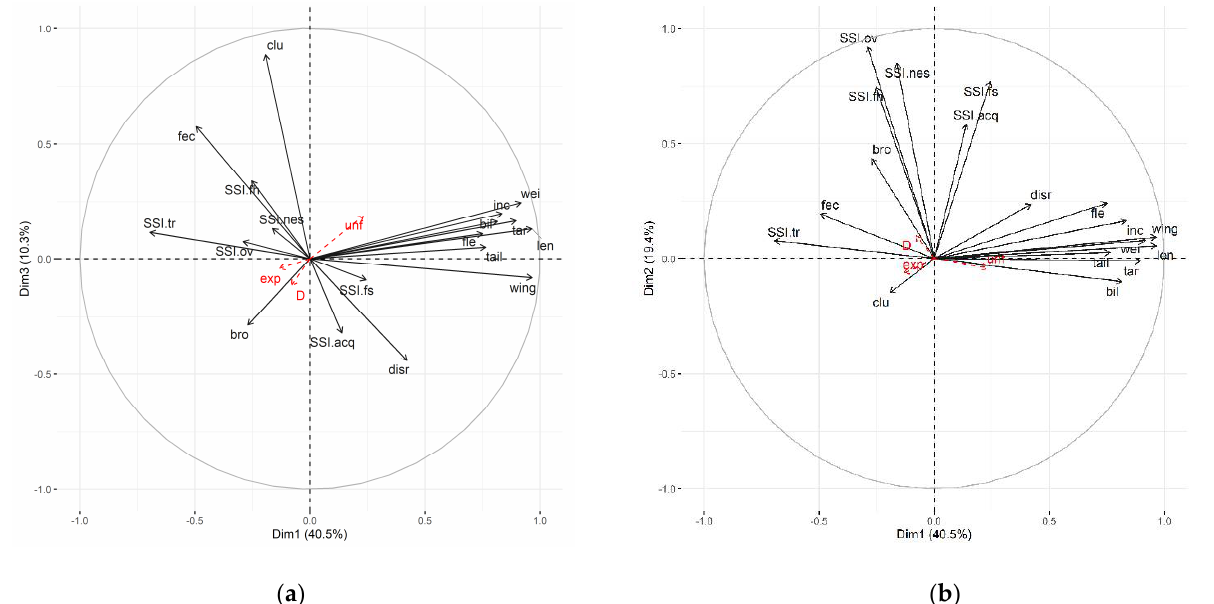
Figure 6. Relationship between niche metrics, life-history and ecological continuous traits. PCA bip- lot between the Schoener’s D (D), unfilling (unf) and expansion (exp) niche metrics (red and dashed arrows) and the 18 continuous traits (solid black arrows) respect to Dim1 and Dim3 ( a ) and to Dim1 and Dim2 ( b ). Abbreviations’ meaning for the continuous traits: len = body length; wing = wing length; tail = tail length; bil = bill length; tar = tarsus length; wei = body weight; clu = clutch size; bro = number of broods per breeding season; fec = annual fecundity; inc = incubation period; fle = fledg- ing period; disr = dispersal ratio; SSI. = prefix for the specialization indices; fh = foraging habitat; acq = acquisition behavior; nes = nesting habitat; fs = foraging substrate; tr = diet; ov = overall. See Table S2 for further details on species traits.